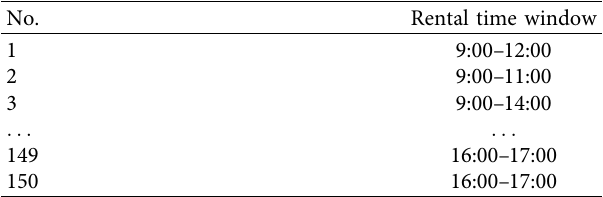
Table 3: Vacant parking spaces in Peace Community.